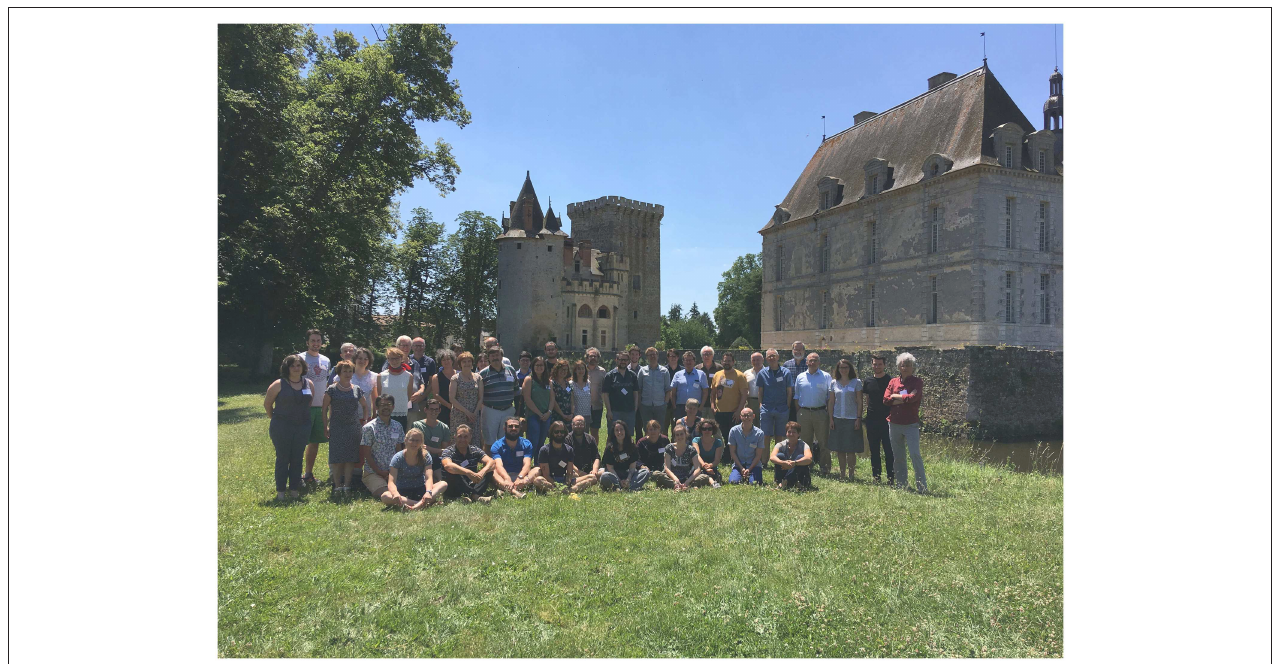
FIGURE 2 | Group picture of the attendees of the Microsoil 2018 workshop, held in the château of Saint Loup Lamairé (Deux Sèvres, France) in June 2018. The group comprised 50 researchers from 7 countries, who for 3 days, debated issues associated with the Research Topic in a very relaxed atmosphere.